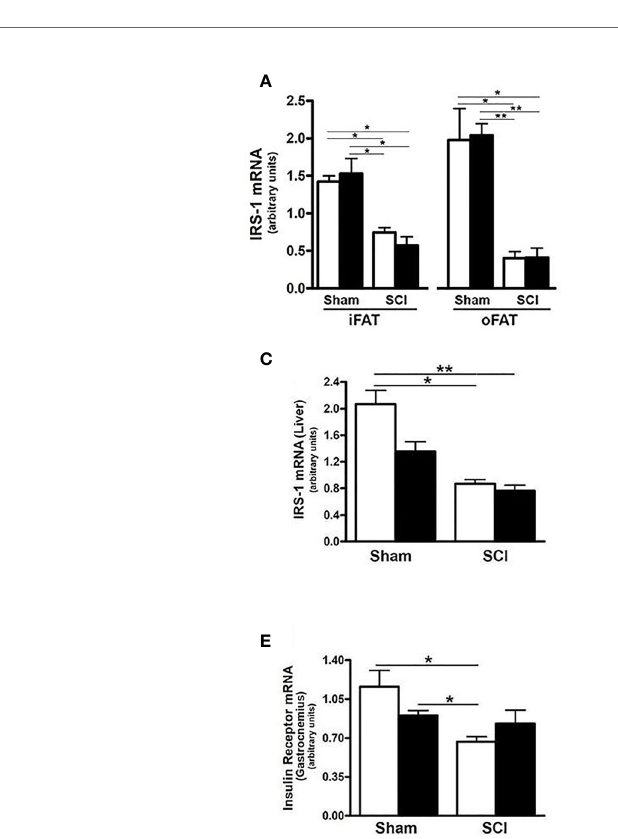
FIGURE 7 | SCI Dysregulated Tissue Speci fi c Expression of Insulin Signaling-Related Genes. Mice were fed with either ConD (White Bar) or HFD (Black Bar) after surgery. Total RNA was isolated from adipose tissues and subjected to Rt-PCR for (A) , IRS-1 mRNA expression, and (B) , Glut4 mRNA expression; (C) , total RNA was isolated from mouse liver and subjected to Rt-PCR for hepatic IRS-1 mRNA expression; (D) , liver glycogen content measured by colorimetric assay; (E) , total RNA was isolated from mouse gastrocnemius and subjected to Rt-PCR for insulin receptor mRNA expression; (F) , colorimetric assay for glycogen content in mouse gastrocnemius. Data shown are mean values ± SEM (n = 5) * p < 0.05; ** p <